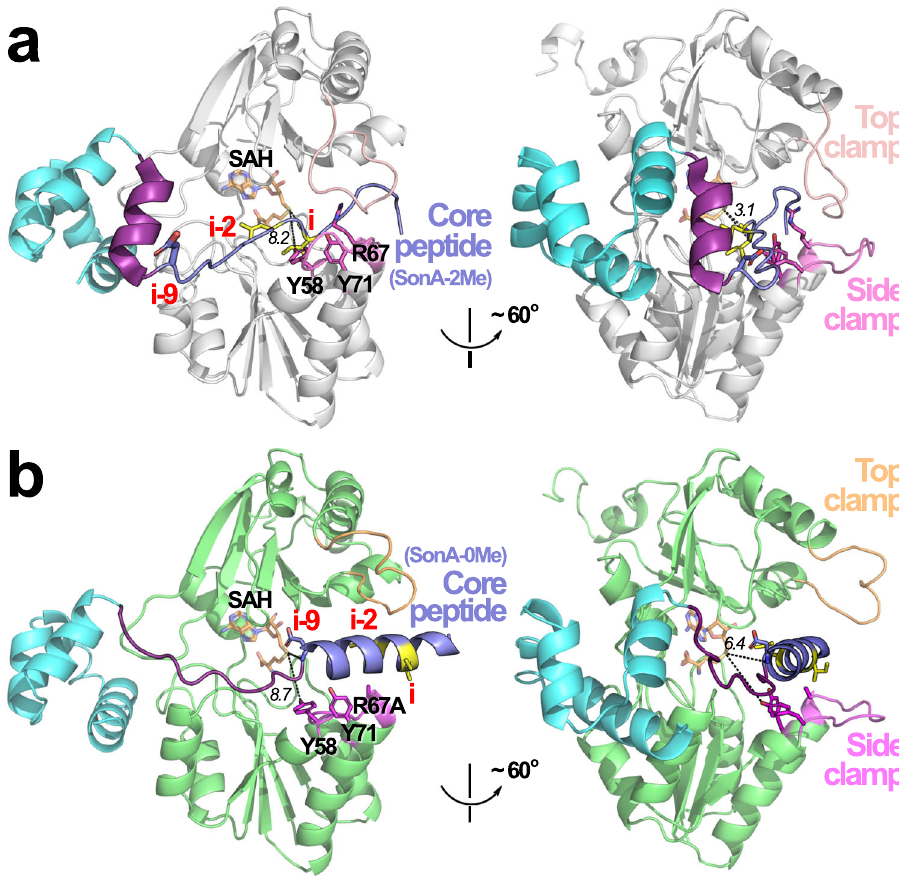
Fig. 7 Global differences in structures of SonM — SonA-2Me — SAH and SonM-R67A — SonA-0Me — SAH complexes. a One SonM — SonA-2Me — SAH heterodimer is shown, where SonM is represented in white cartoon, the BBD of SonA-2Me is shown in cyan cartoon, and the core peptide is shown in slate. α - N -Methylated residues “ i ” and “ i – 2 ” are depicted as yellow sticks. Helix 5 of the BBD is highlighted purple. The two structures in this panel are rotated ~60 degrees to view the structure from two different perspectives. b One SonM-R67A — SonA-0Me — SAH heterodimer is shown, where SonM is represented in light green cartoon, and all other portions of the structure are colored and depicted as in a . Note that residues “ i ” and “ i − 2 ” are not methylated in this structure as SonM-R67A is an inactive mutant. Key distances are depicted as black dashed lines and their lengths noted in italics in Ångstroms. In comparison to a , the SonM-R67A — SonA-0Me — SAH complex reveals a pre-reacted state, where the top lock and clamps are open and the core peptide is more than 3 Å farther away from the cofactor. More signi fi cantly, the core peptide is α -helical and positions deeper into the active site, resulting in the BBD helix 5 being unwound into a